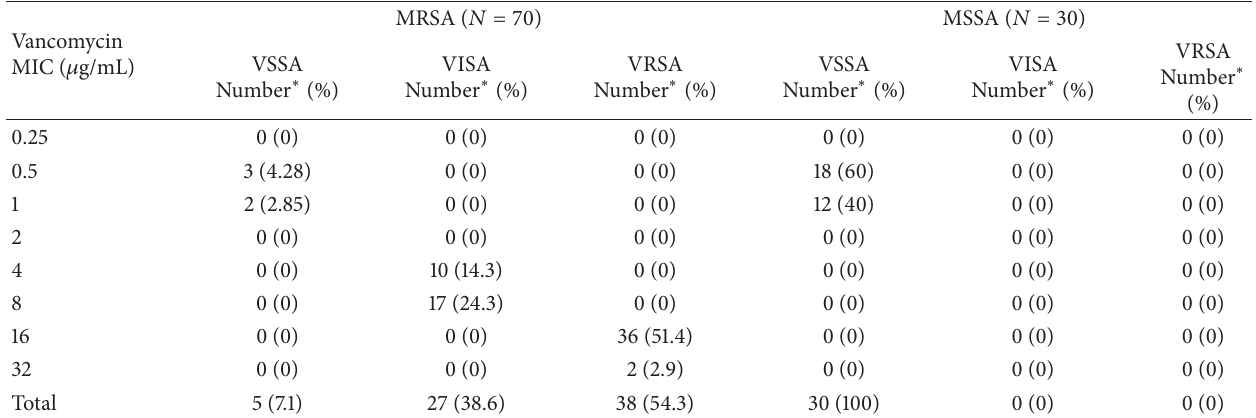
Table 6: Minimum inhibitory concentration of vancomycin of Staphylococcus aureus clinical isolates.